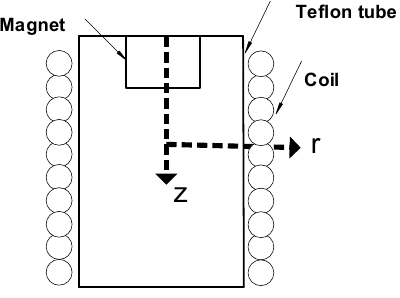
Figure 8. A cylindrical magnet at a distance r from the coil